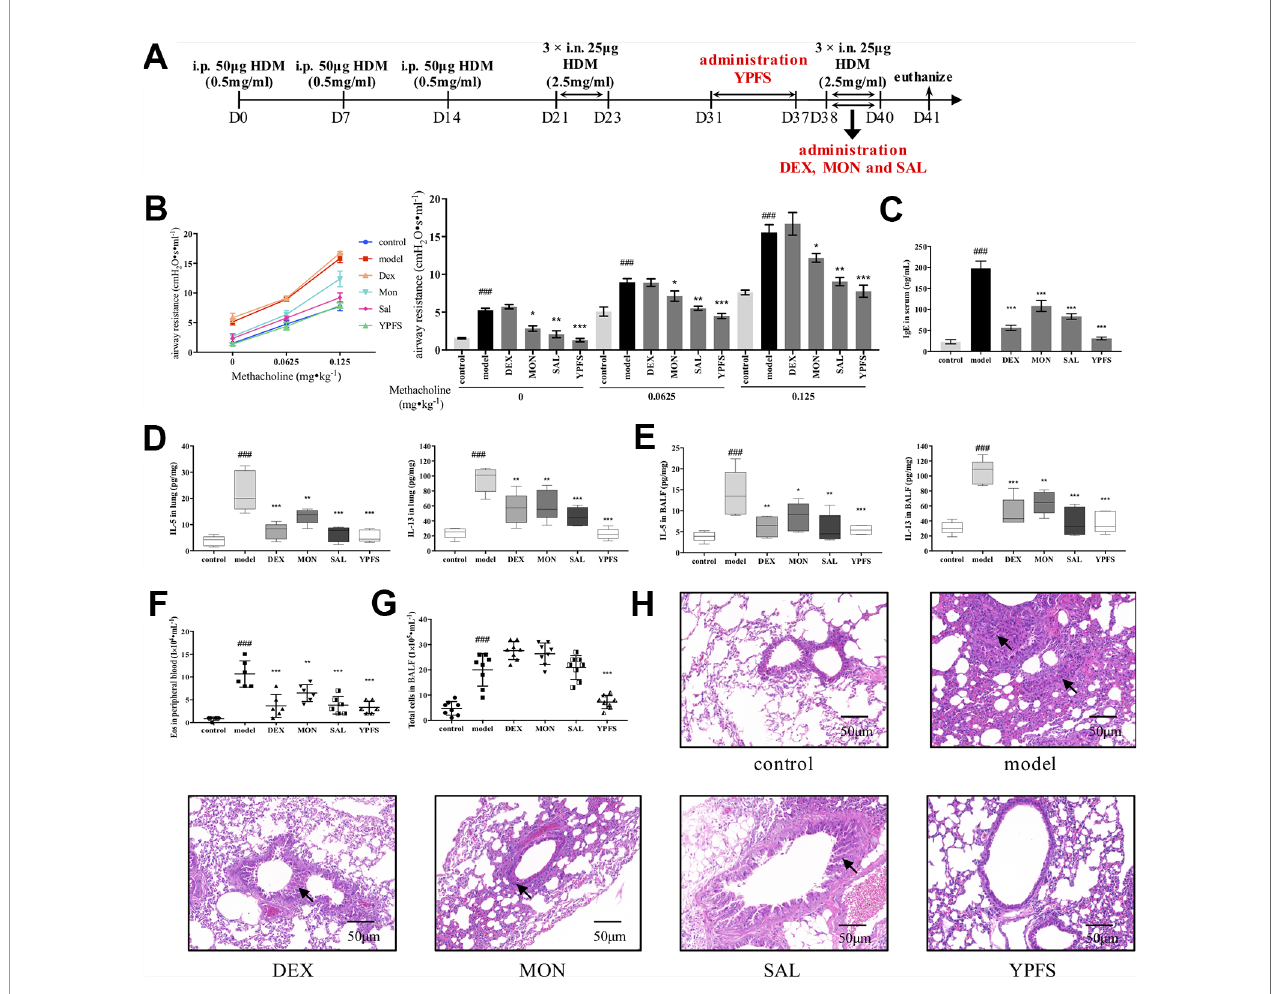
FIGURE 3 | Administration of YPFS during remission period exerted more potent ef fi ciency than three medications used during second elicitation against asthma recurrence. Since DEX, MON and SAL are commonly used when asthma exacerbates, we next administered YPFS and three medications DEX, MON, and SAL in remission and recurrence phases, respectively, to compare their ef fi cacy against asthma recurrence. (A) dosage regimen of YPFS, DEX, MON, and SAL on the HDM-induced asthma recurrence model; 24 h after last elicitation, (B) AHR of mice was evaluated by measuring airway resistance to methacholine. The bar chart portrayed statistical analysis of airway resistance data under stimulation of each concentration of methacholine; (C) IgE in serum was detected by ELISA; IL-5 and IL- 13 in (D) lung homogenates and (E) BALF were detected; (F) Eosinophils in peripheral blood, and (G) total cells in BALF were counted. (All data represent mean ± SD from three independent experiments performed in triplicate, n = 8, * P < 0.05, ** P < 0.01, *** P < 0.001 versus model; ### P < 0.001 versus control); (H) Histological changes of lung sections were determined by H&E staining (n = 8; scale bar = 50 m m). Black solid arrows indicated that DEX, MON and SAL alleviated in fl ammatory in fi ltration but showed negligible ef fi cacy against bronchial wall thickening. In contrast, YPFS substantially diminished both in fl ammatory in fi ltration and thickened bronchial wall. YPFS, Yu-Ping-Feng-San; DEX, dexamethasone; MON, montelukast; SAL, salbutamol; BALF, bronchoalveolar lavage fl